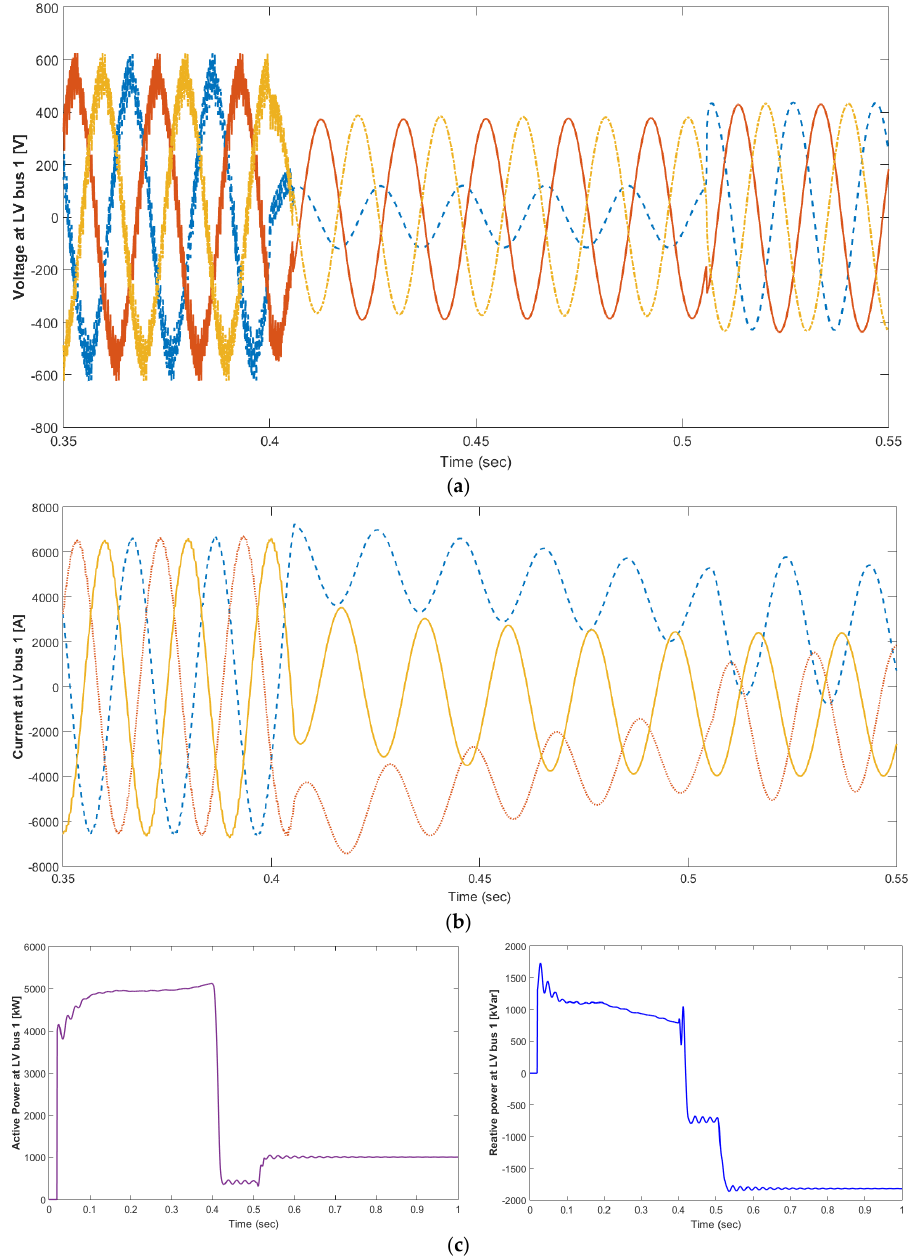
Figure 12. ( a ). Voltages in the LV park bus during one-phase-to-ground fault at the 22 kV side. ( b ) Currents in the LV park bus during one-phase-to-ground fault at the 22 kV side. ( c ). Active and reactive power at the LV bus during one-phase-to-ground fault.